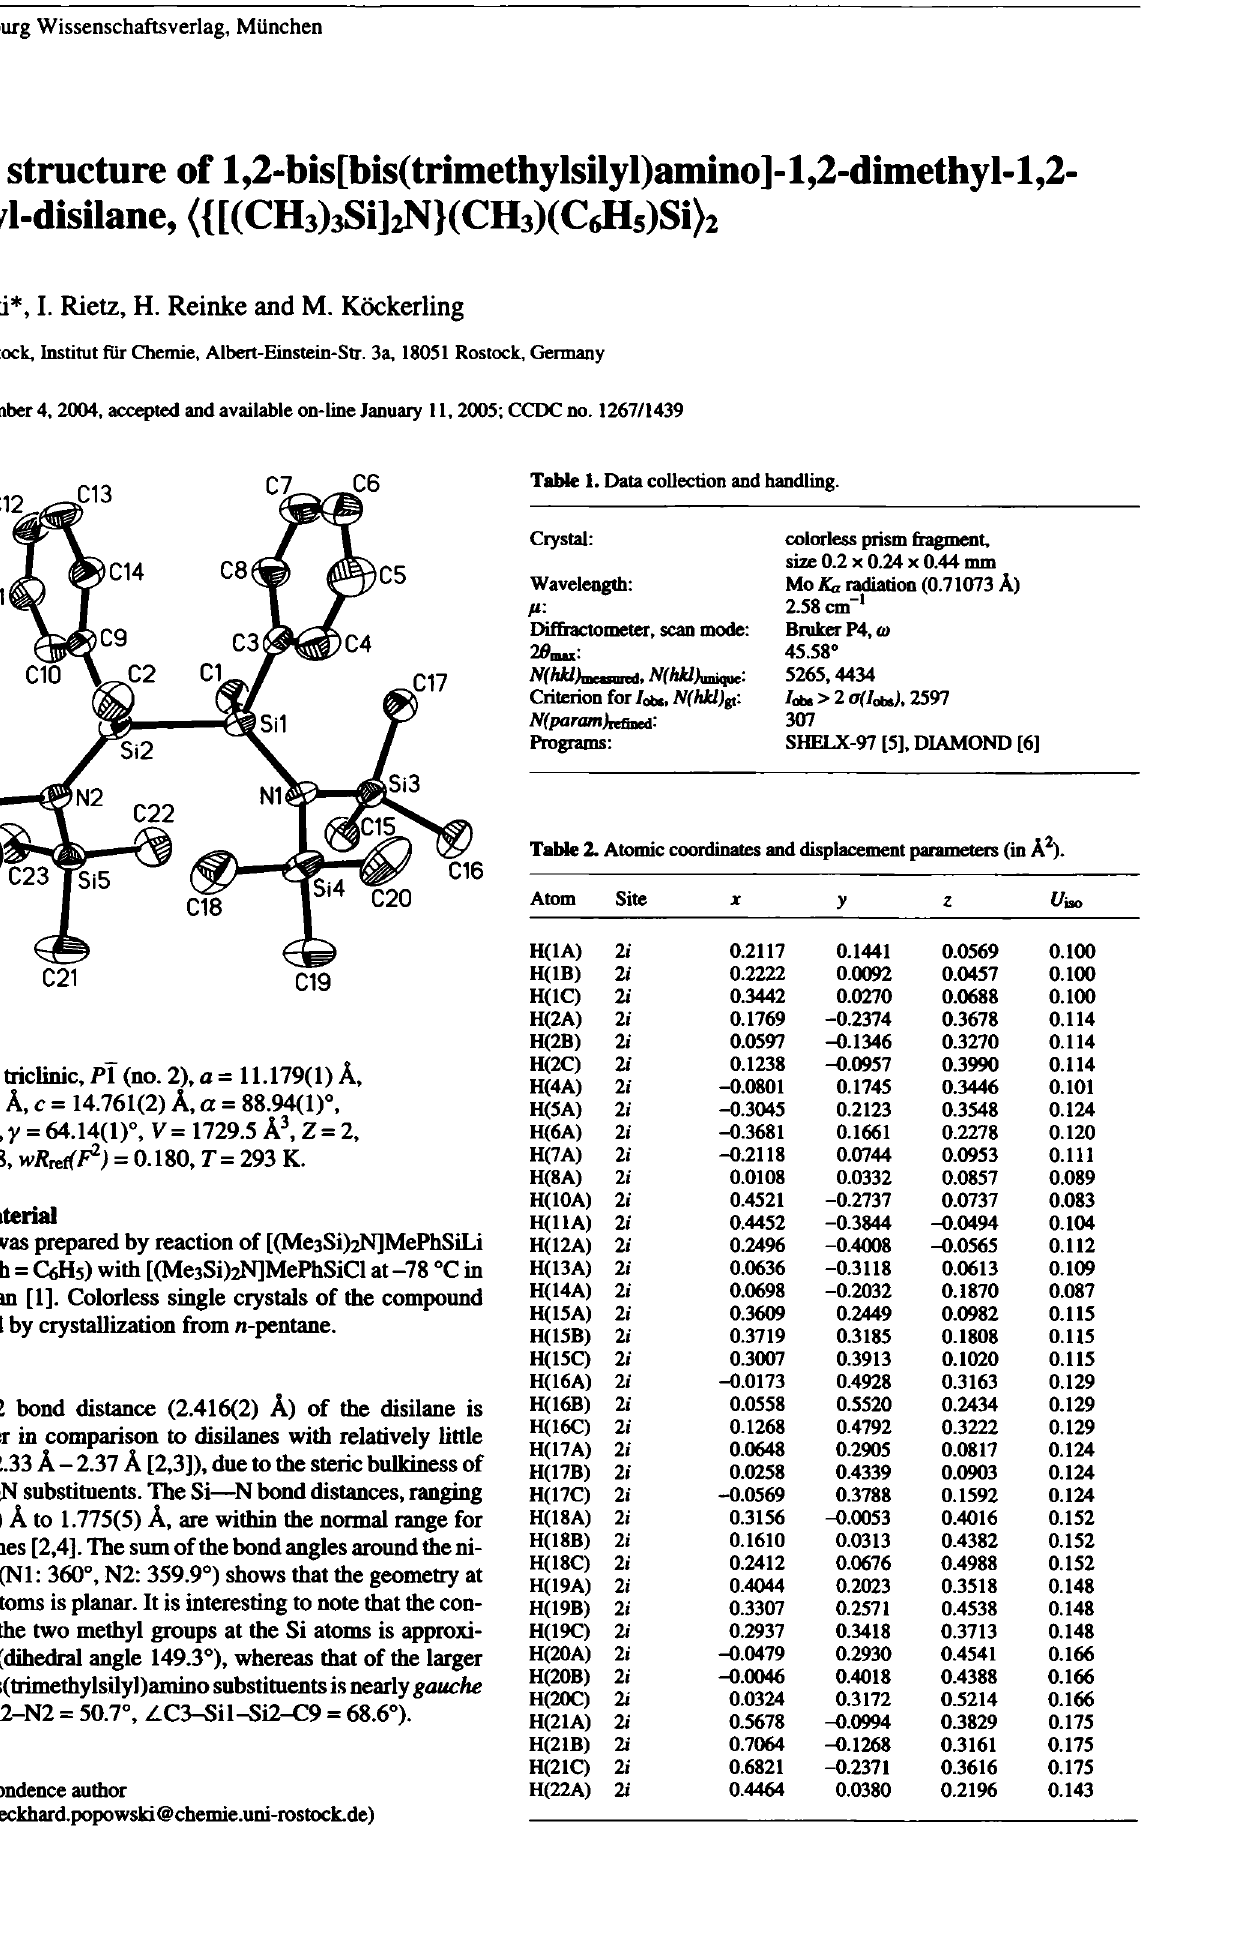
Table 1. E>ata collection and handling.